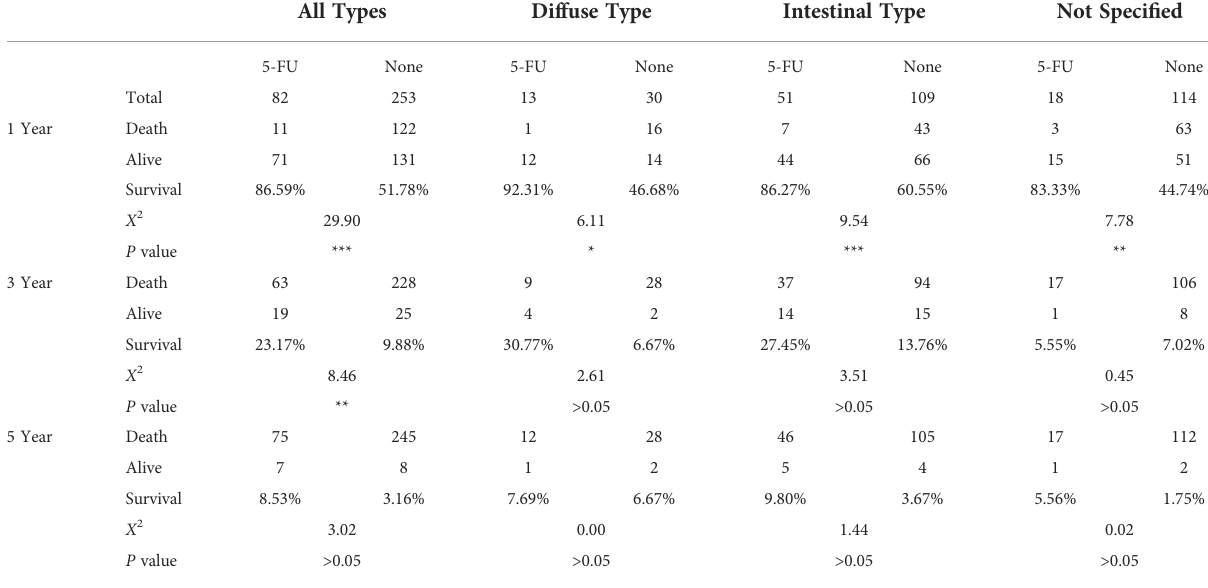
TABLE 1 Survival times of STAD samples from TCGA online database. All